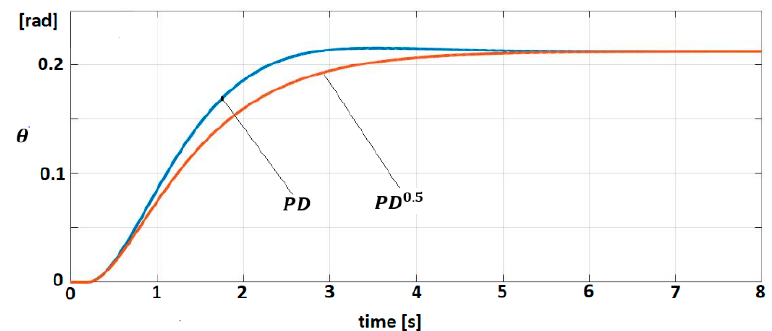
Figure 8 . Trajectory 𝜃(𝑡) for PD 0.5 and PD Figure 8. Trajectory θ ( t ) for PD 0.5 and PD